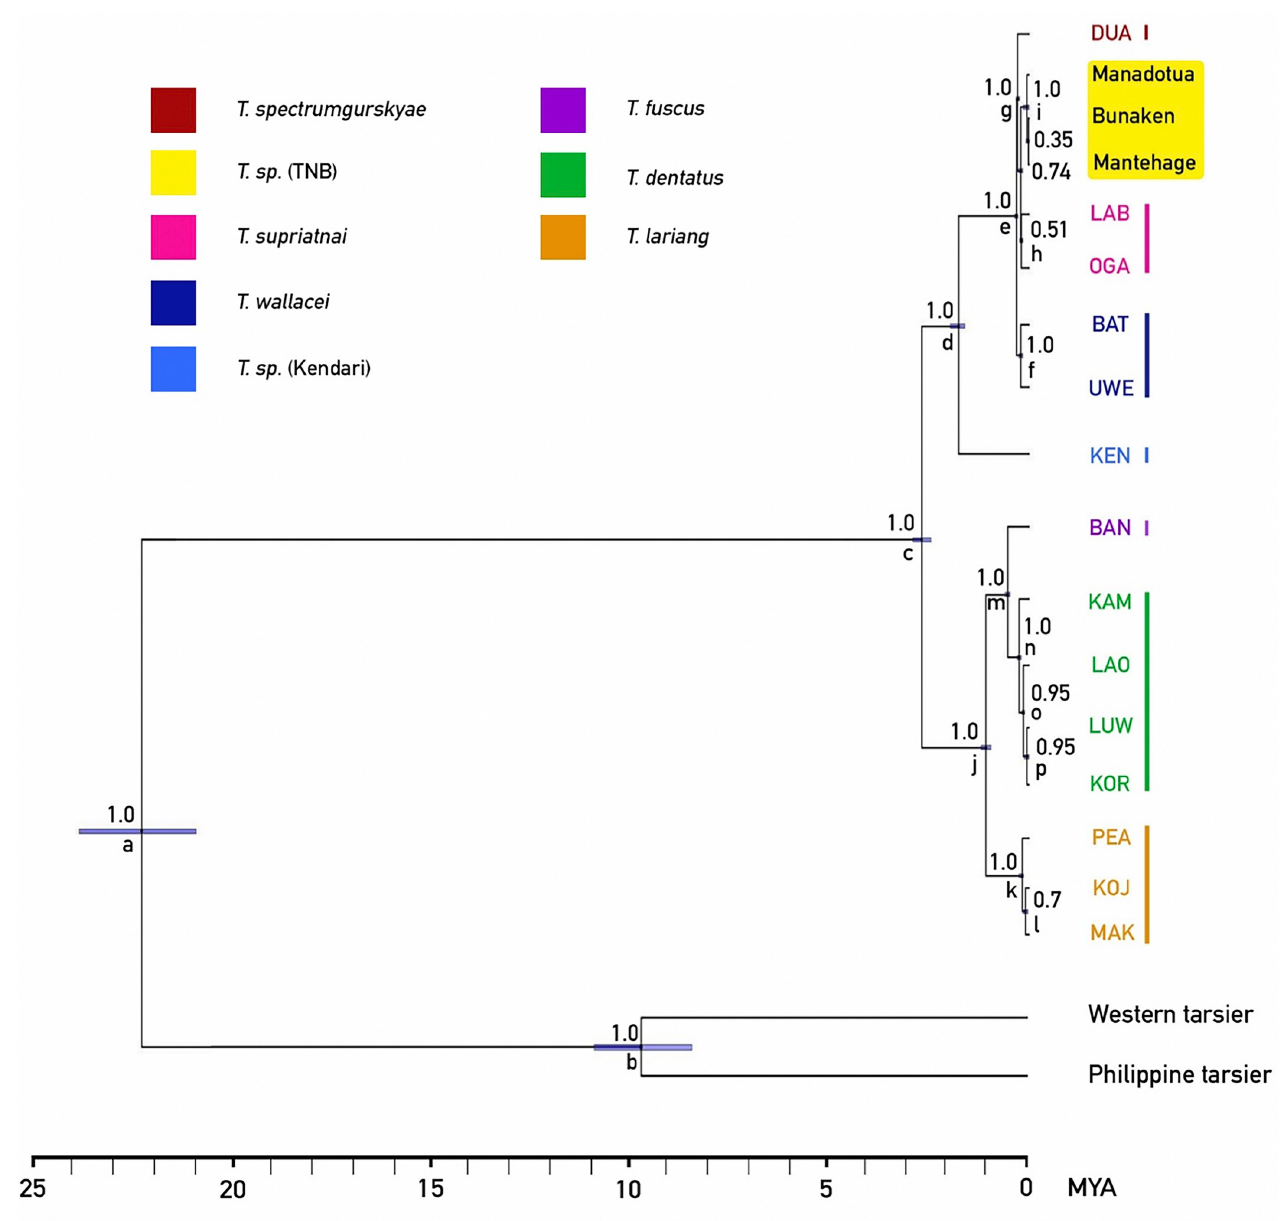
Fig 6. Time-calibrated multilocus Bayesian tree. Numbers above nodes are posterior probability (pp) and 95% confidence intervals are indicated with purple bars. Lowercase letters indicate nodes’ names (see Table 3). Study populations are yellow highlighted.